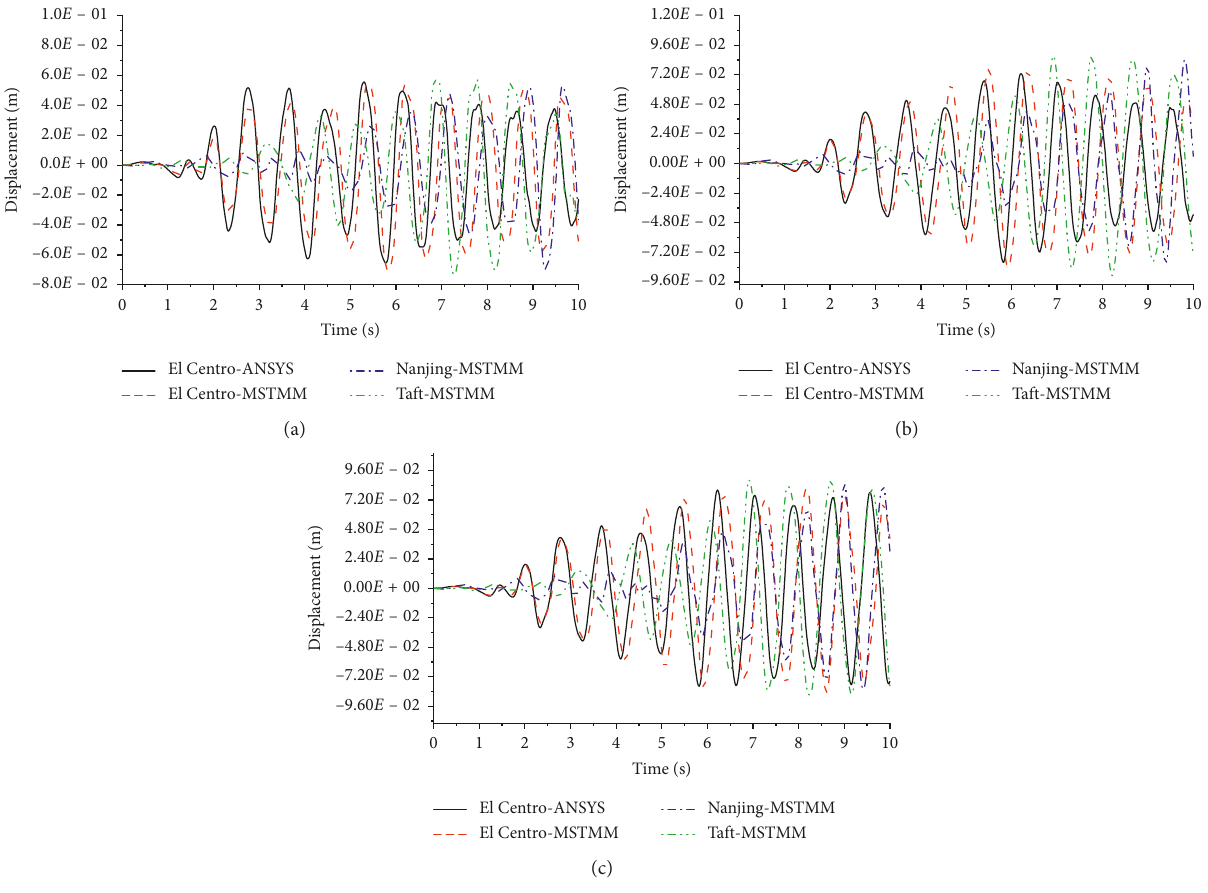
2 ). (a) 10mm, (b) 40mm, and (c)